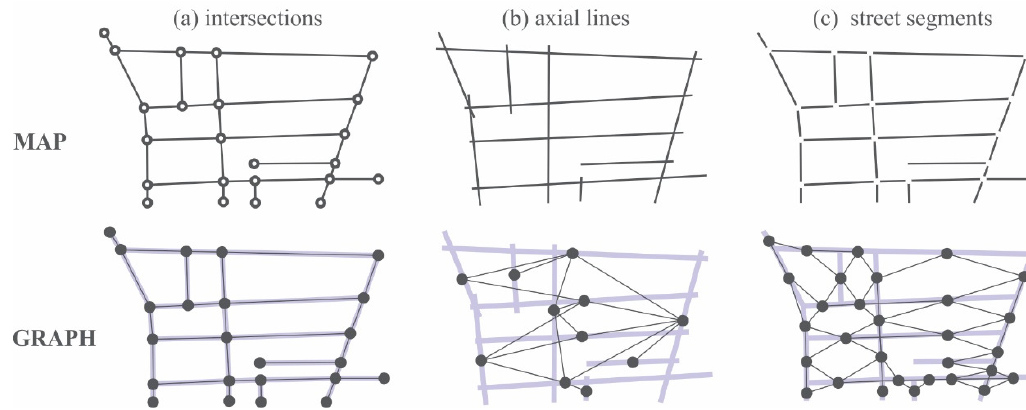
Figure 1. Three ways to represent the urban system as maps with discrete units and their corresponding graph: ( a ) intersections; ( b ) axial lines; ( c ) street segments. Source: Authors, January 2018.